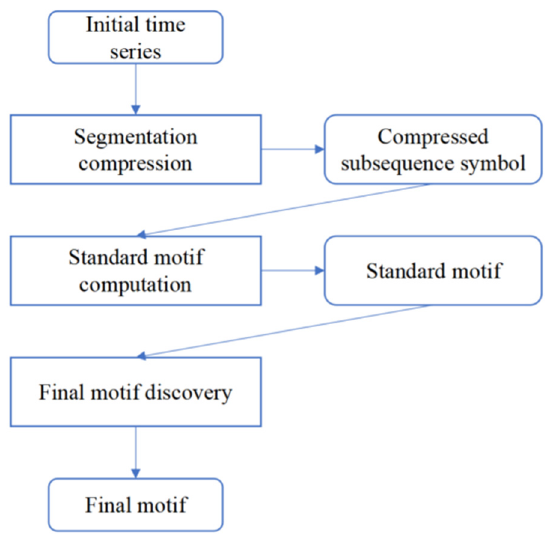
Figure 4. Main steps of MDLats.